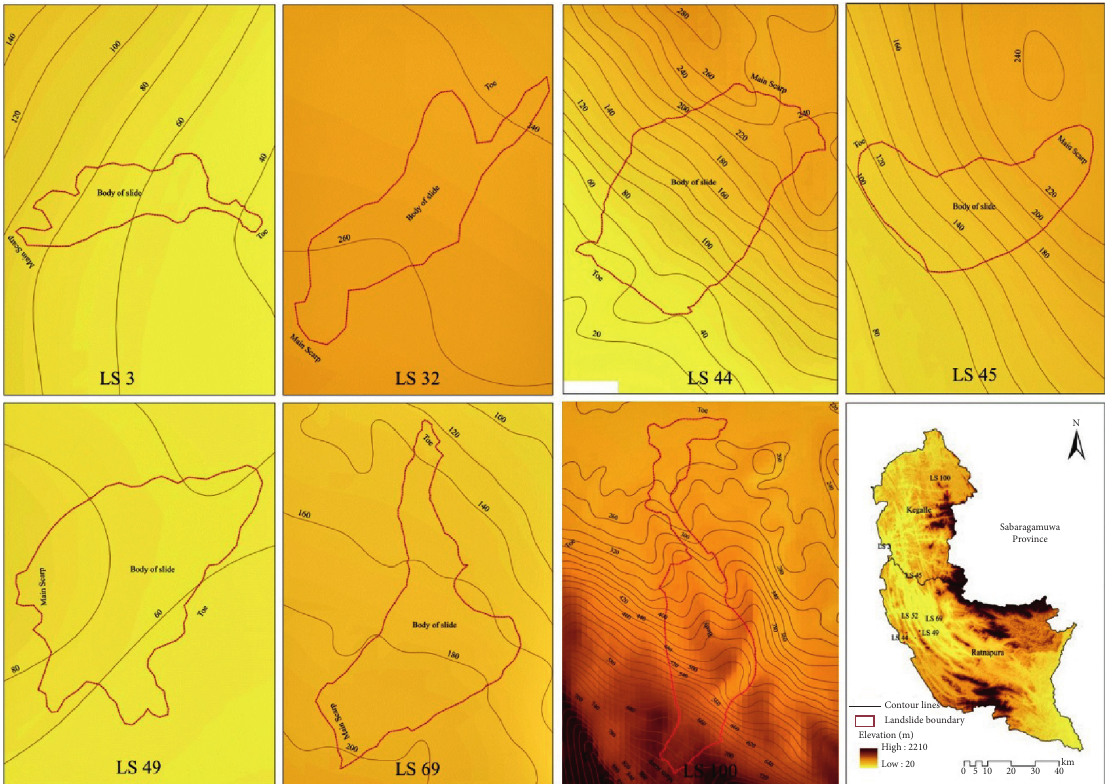
Figure 7: Map of a polygon of selected landslides extracted from the PLI web portal.